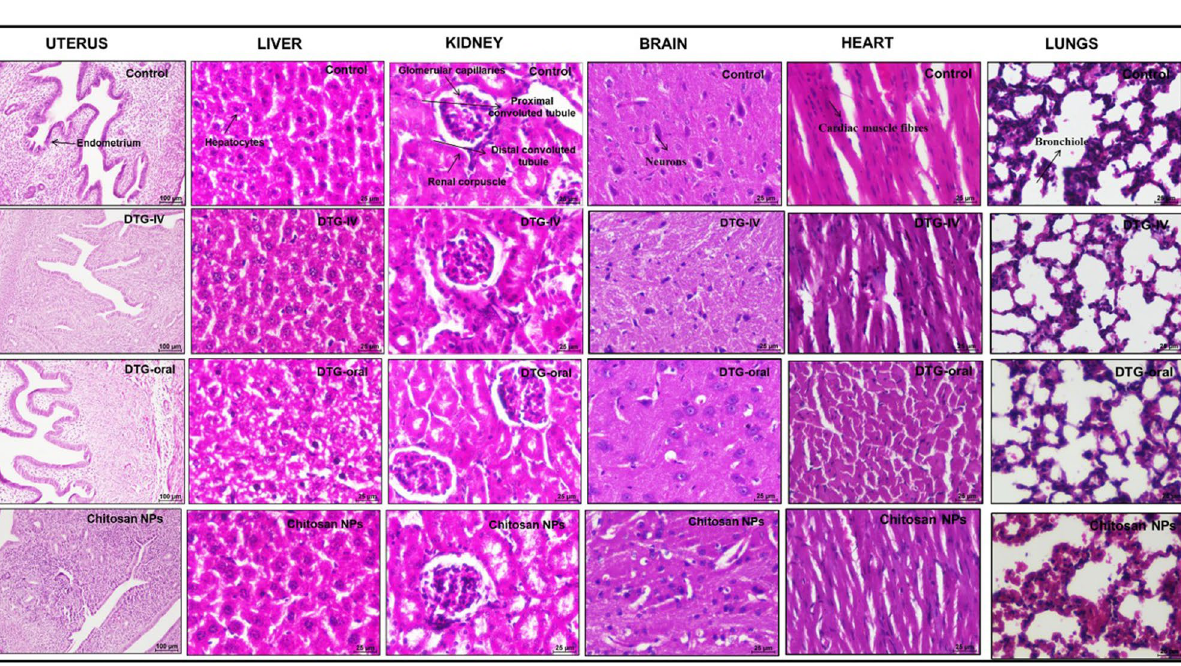
Figure 5. Organ biodistribution of the drug in Chitosan NPS compared with pure drug in the treated animals.